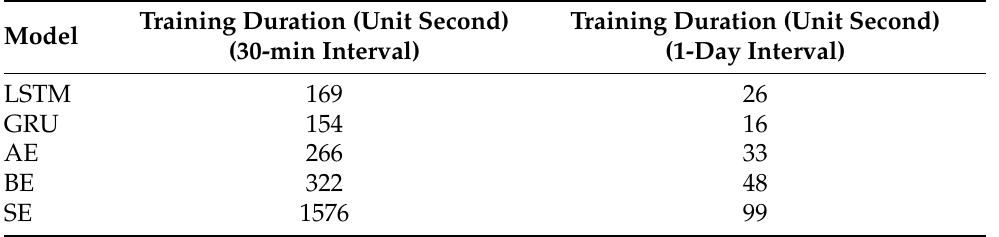
Table 3. Time complexity and training duration of